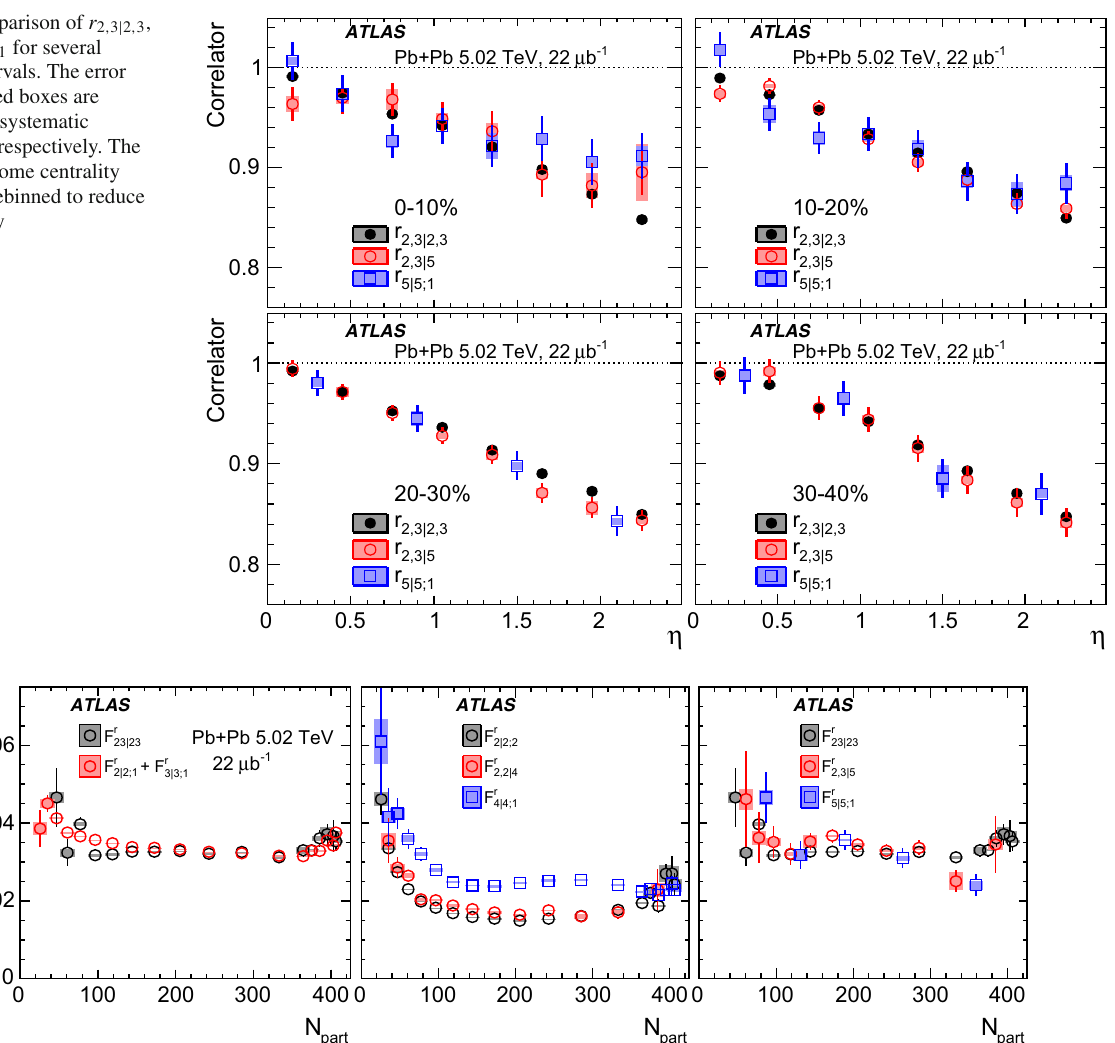
Fig. 24 Comparison of the slopes of the correlators as a function of N part for three groups of correlators: r 2 , 3 | 2 , 3 and r 2 | 2 ; 1 r 3 | 3 ; 1 (for which the slope is F 2 | 2 ; 1 + F 3 | 3 ; 1 ) in Fig. 21 (left panel), r 2 | 2 ; 2 , r 2 , 2 | 4 and r 4 | 4 ; 1